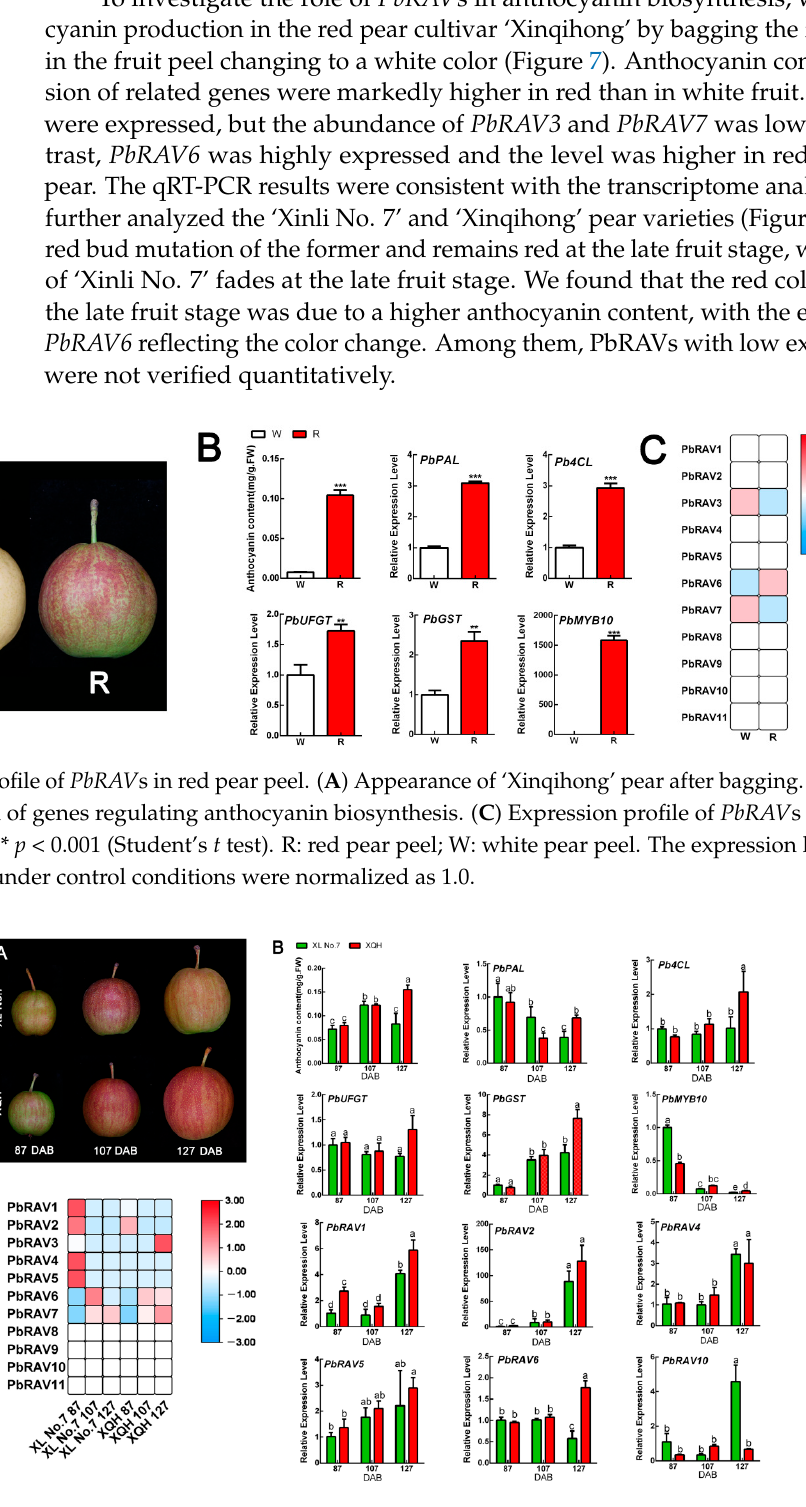
Figure 8. Expression profiles of PbRAV s in two pear cultivars during the fading period. ( A ) Morphological changes in ‘Xinli No. 7 ′ and ‘Xinqihong’ pear varieties during the fading period. ( B ) Anthocyanin content, expression of genes regulating anthocyanin biosynthesis, and expression of PbRAVs. ( C ) Expression profile of PbRAV s in the two pear cultivars. Different lowercase letters indicate statistical significance at p < 0.05 (Duncan’s test). The expression levels of genes in the peel of ‘Xinli No. 7 ′ pear at 87 DAB were normalized as 1.0. DAB: days after full bloom.